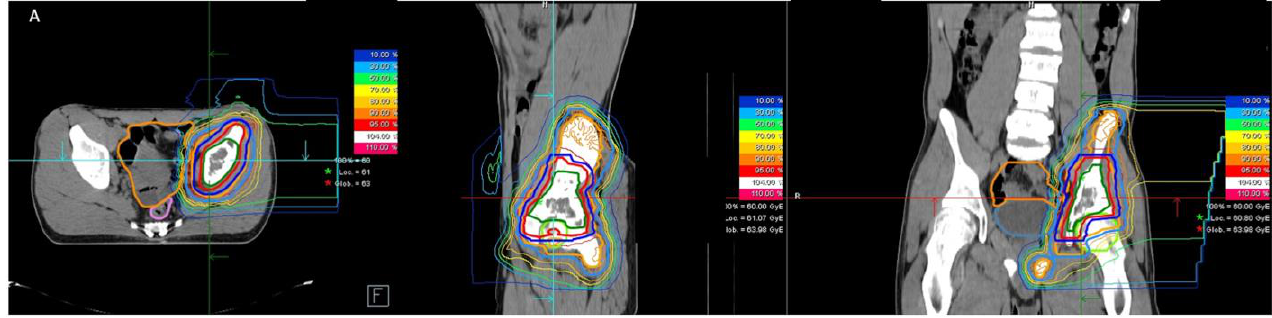
Figure 1. ( A – C ): Examples of three patients with primary pelvic Ewing sarcoma undergoing proton therapy. Figure 2. Example of a patient with locally recurrent pelvic Ewing sarcoma undergoing carbon ion radiotherapy. Data Collection and Study Endpoints The study was approved by the Ethics Committee of the University of Heidelberg. Data on patient, tumor and treatment characteristics were collected from the medical rec- ords and the research platform of the Heidelberg Institute for Radiation Oncology. Mor- bidity was scored based on CTCAE version 5. Disease outcome was evaluated for local recurrence (LC), distant recurrence and disease control (DC). Local recurrence was de- fined as any relapse within the pelvis, distant recurrence as any other recurrence and dis- ease control defined by any disease recurrence. Overall survival (OS) was defined by death from any cause. Time-to-event intervals were calculated from the date of biopsy to